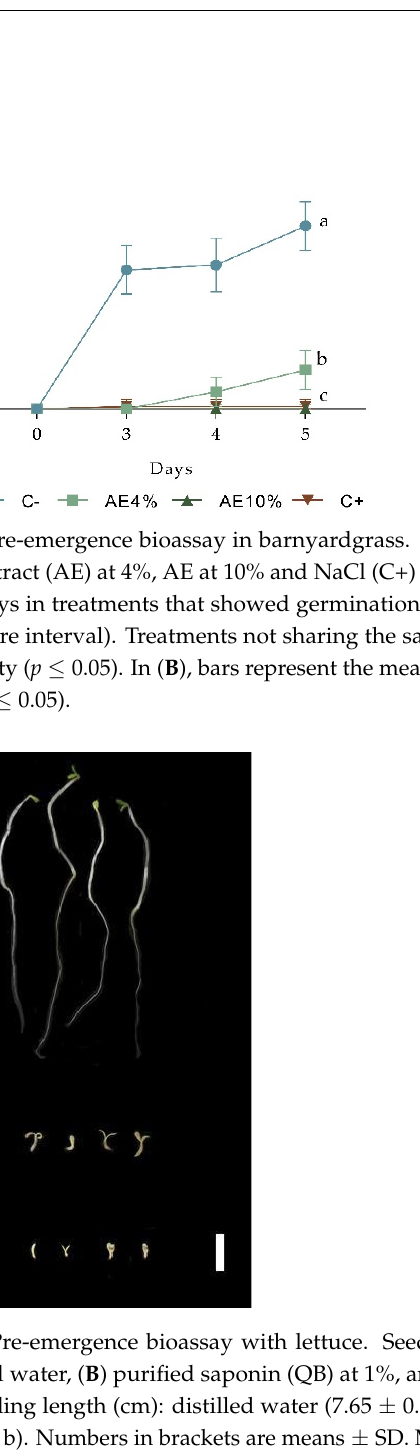
Figure 1. Pre-emergence bioassay with lettuce. Effects of ( A ) aqueous extracts (AE) (at 4 and 10%) and ( B ) saponin fraction (QB) (at 1 and 2%) on the number of germinated seeds of L. sativa at the end of 4 days and 8 days, respectively. C- represents the negative control (distilled water), and C+ represents the positive control (NaCl). Bars show 95% confidence intervals (Wilson score interval).